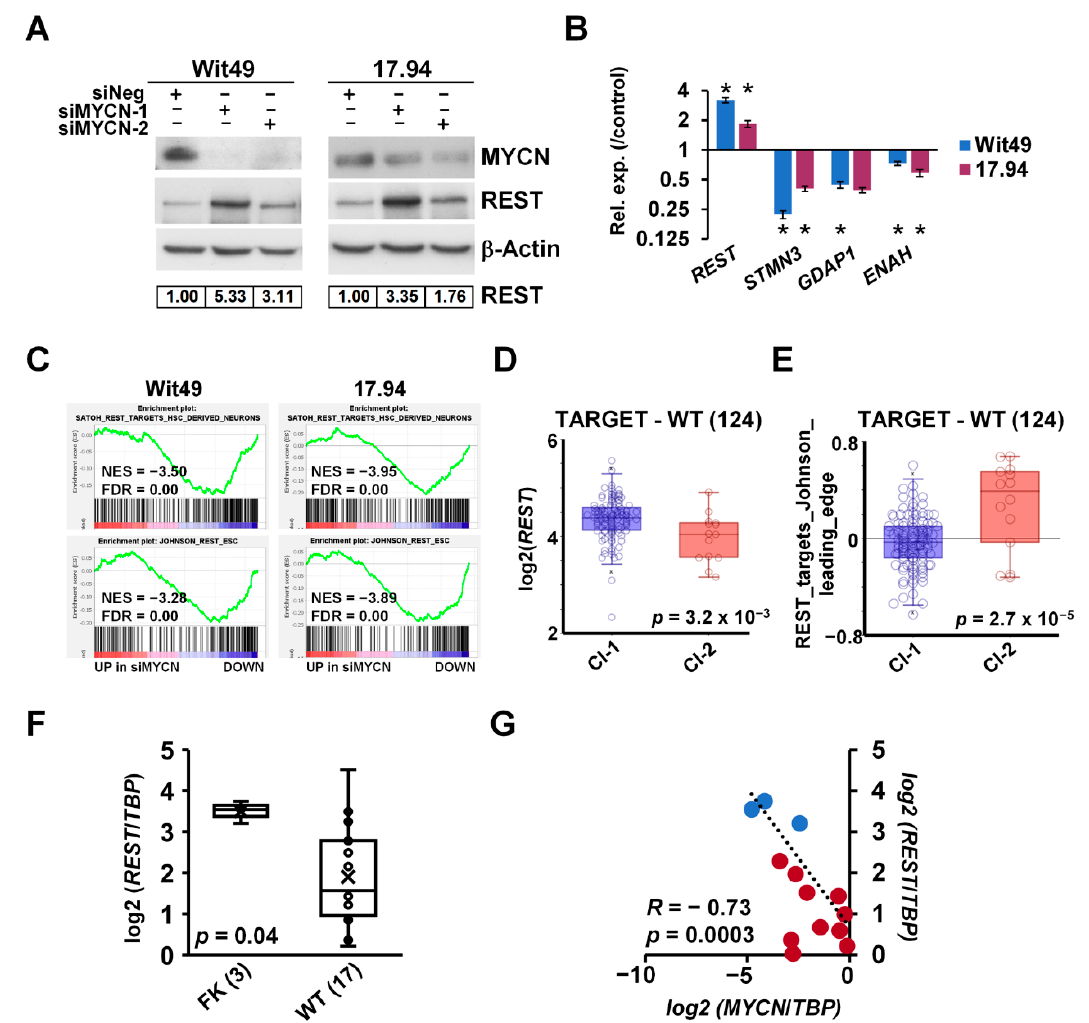
Figure 7. MYCN represses the WT predisposition gene REST. ( A ) REST protein is derepressed upon MYCN depletion ( n = 3). Protein expression was calculated based on densitometry and normalised for loading control. ( B ) Validation of the upregulation of REST mRNA and downregulation of its target genes by qPCR after MYCN depletion for 48 h ( n = 3). A representative experiment is shown. t -tests were performed on biological replicates (* p < 0.05). ( C ) GSEA showed downregulation of REST target genes with MYCN depletion. ( D ) REST has a significantly lower expression in Cluster 2 tumours in the TARGET-WT dataset (SRP012006) as compared with Cluster 1 (ANOVA). ( E ) REST target genes, showing a significant overall overexpression in Cluster 2 WT as compared with Cluster 1. (ANOVA) ( F ) REST was found to be significantly repressed in WT as compared with FK by qPCR, as assessed by a t -test. ( G ) Expression of MYCN and REST was highly and significantly correlated in WT and FK, indicated by red and blue dots, respectively. Uncropped Western blots are available in Figure S5D.